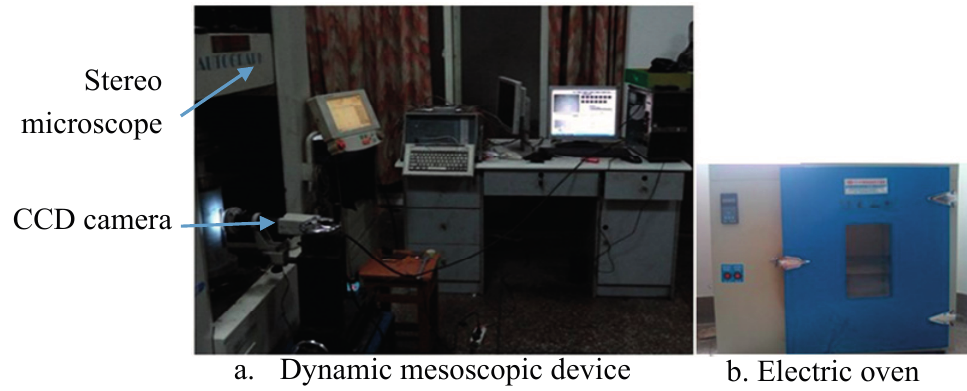
Figure 1. Test equipment.